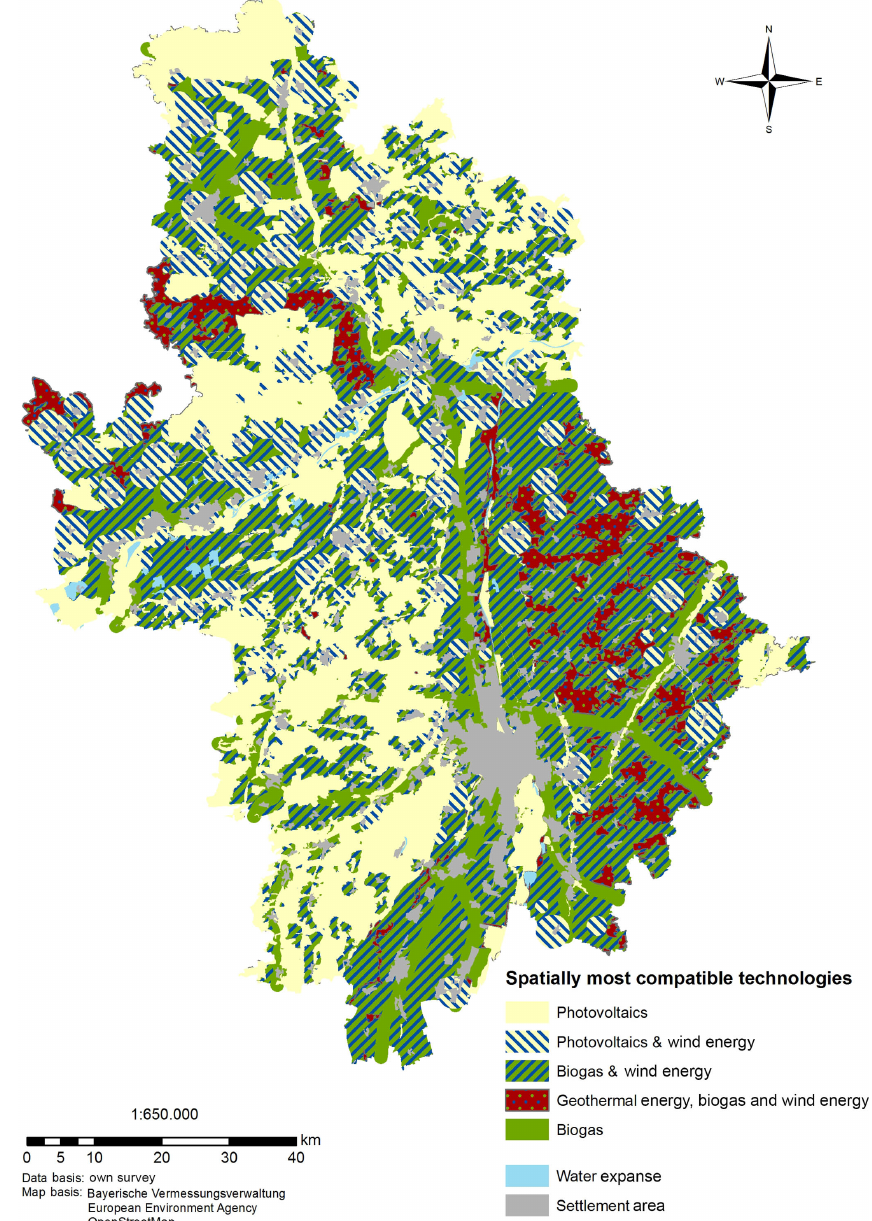
Figure 2. Spatially compatible assignment of technologies – current technological